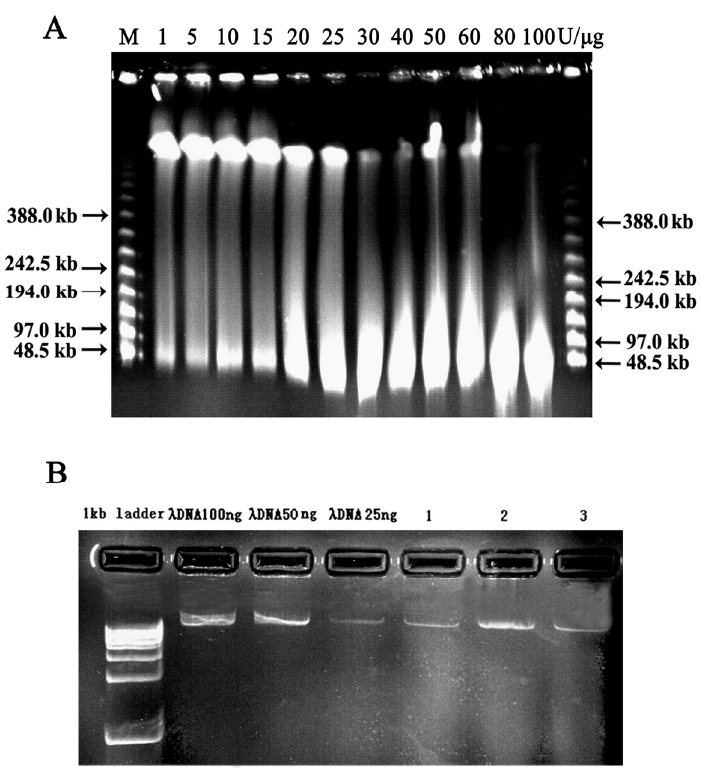
Figure 2. Characterization of digested BAC vector and PFGE size fractionation of digested HMW genomic DNA by Hin d ІІІ . ( A ) Initial PFGE size fractionation of partially digested HMW; M: Lambda Ladder PFG Marker; 1, 5, 10, 15, 20, 25, 30, 40, 50, 60, 80 and 100 U/ μ g DNA respectively; ( B ) Quantification of Siberian tiger genomic